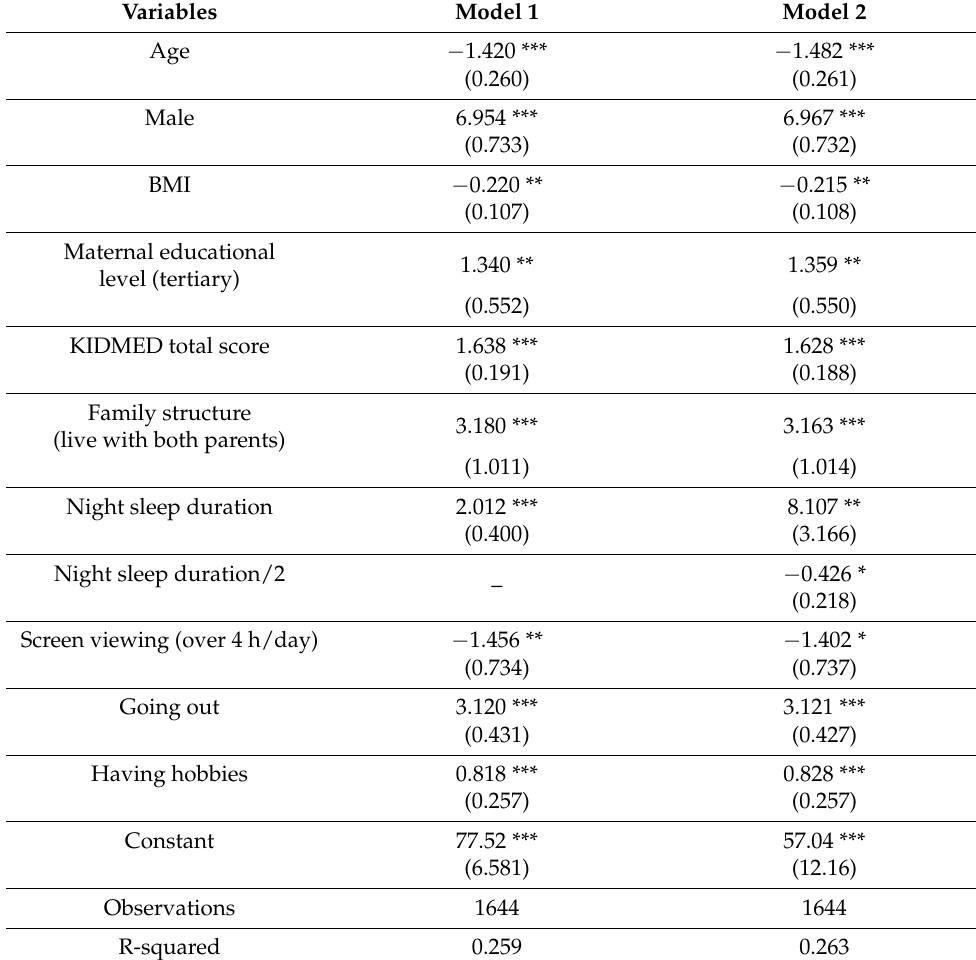
Table 4. Regressions